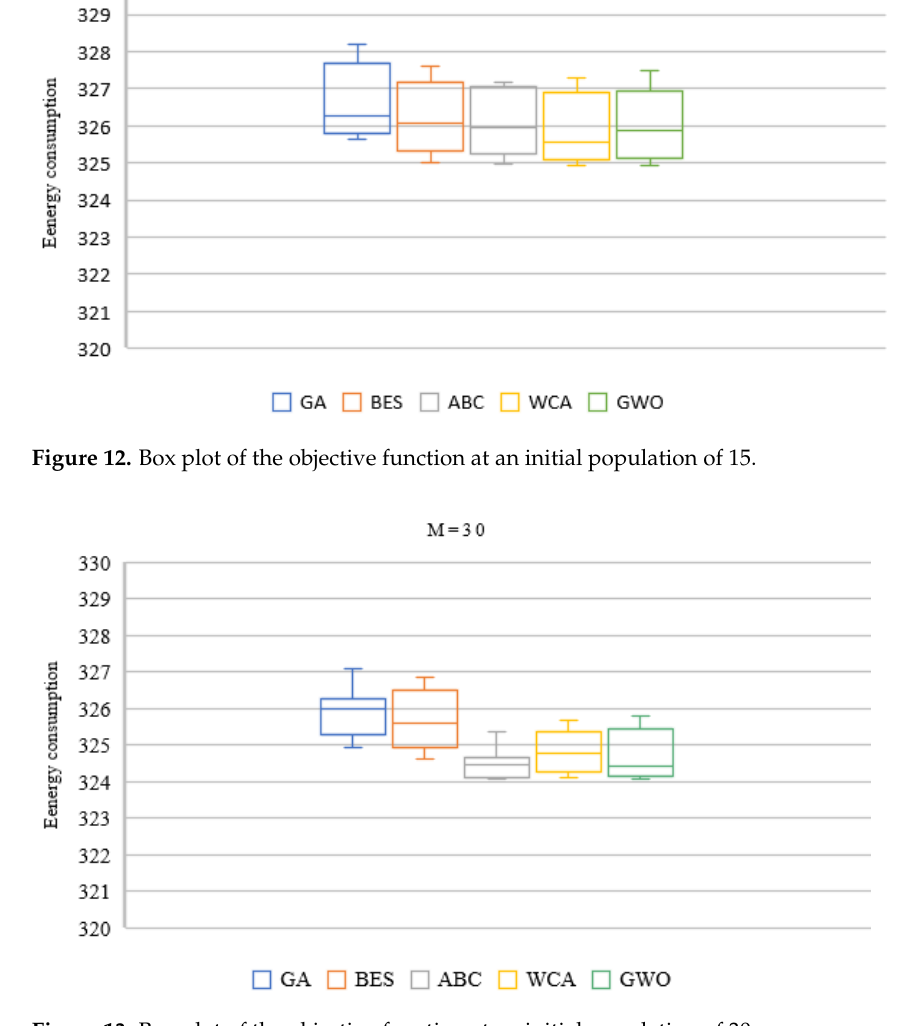
Figure 13. Box plot of the objective function at an initial population of 30.